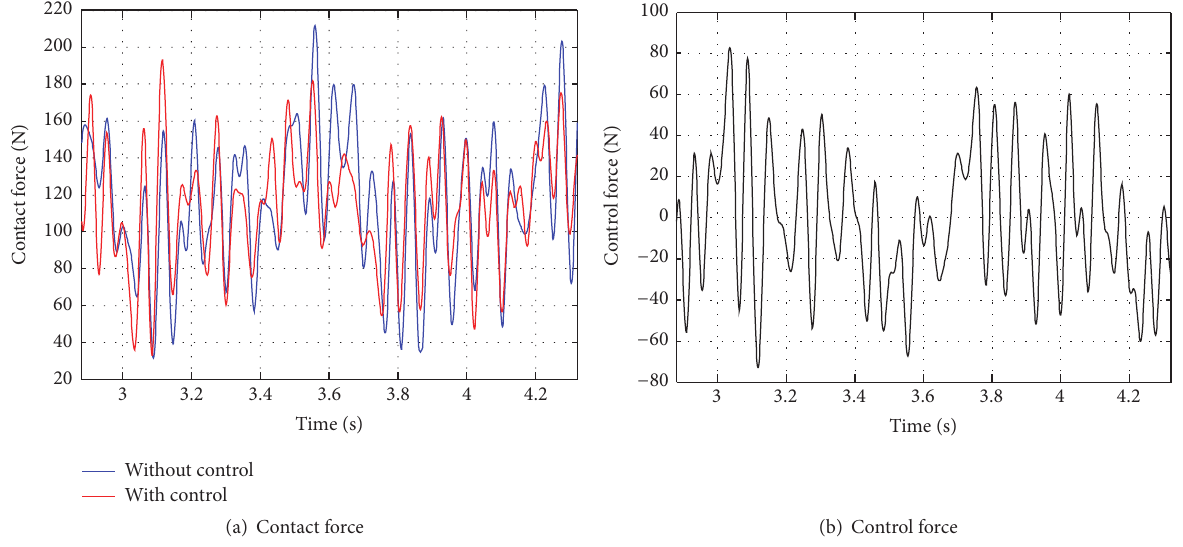
Figure 22: Results of the contact force and control force with EN 50318 reference